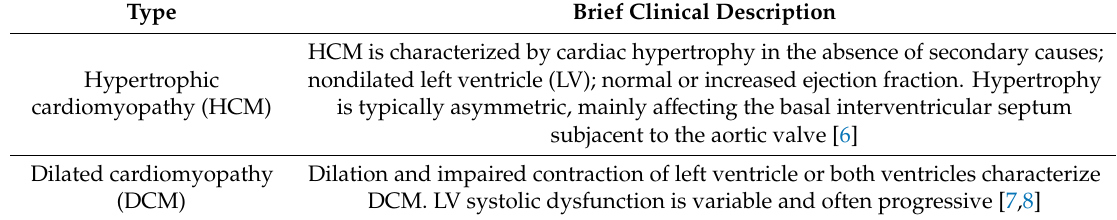
Table 1. Schematic overview of the characteristics of certain cardiomyopathies hereby discussed. Type Brief Clinical